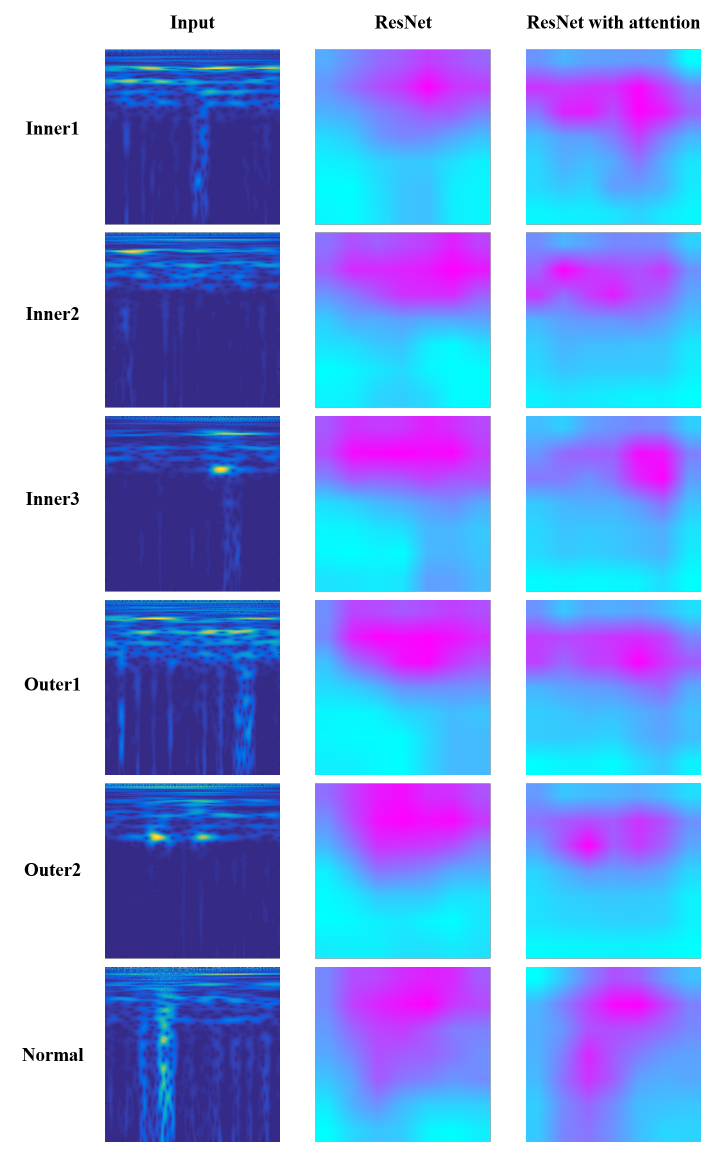
Figure 16. Grad-CAM visualization results of proposed method